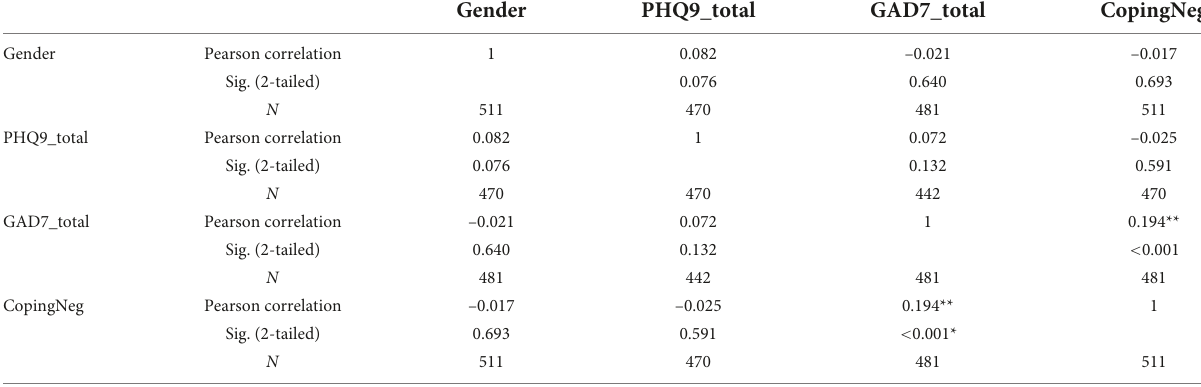
TABLE 2 Means, standard deviations, and zero-order correlations between all